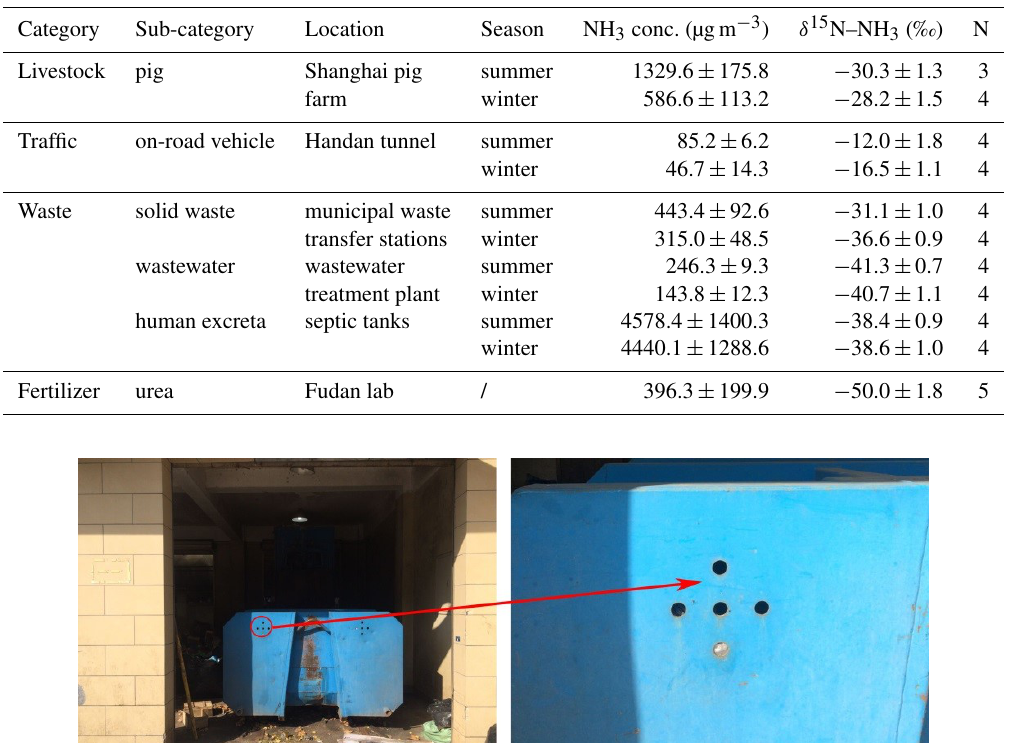
Table 1. δ 15 N–NH 3 values of ammonia sources, source location, and summer–winter comparison (mean ± SD).